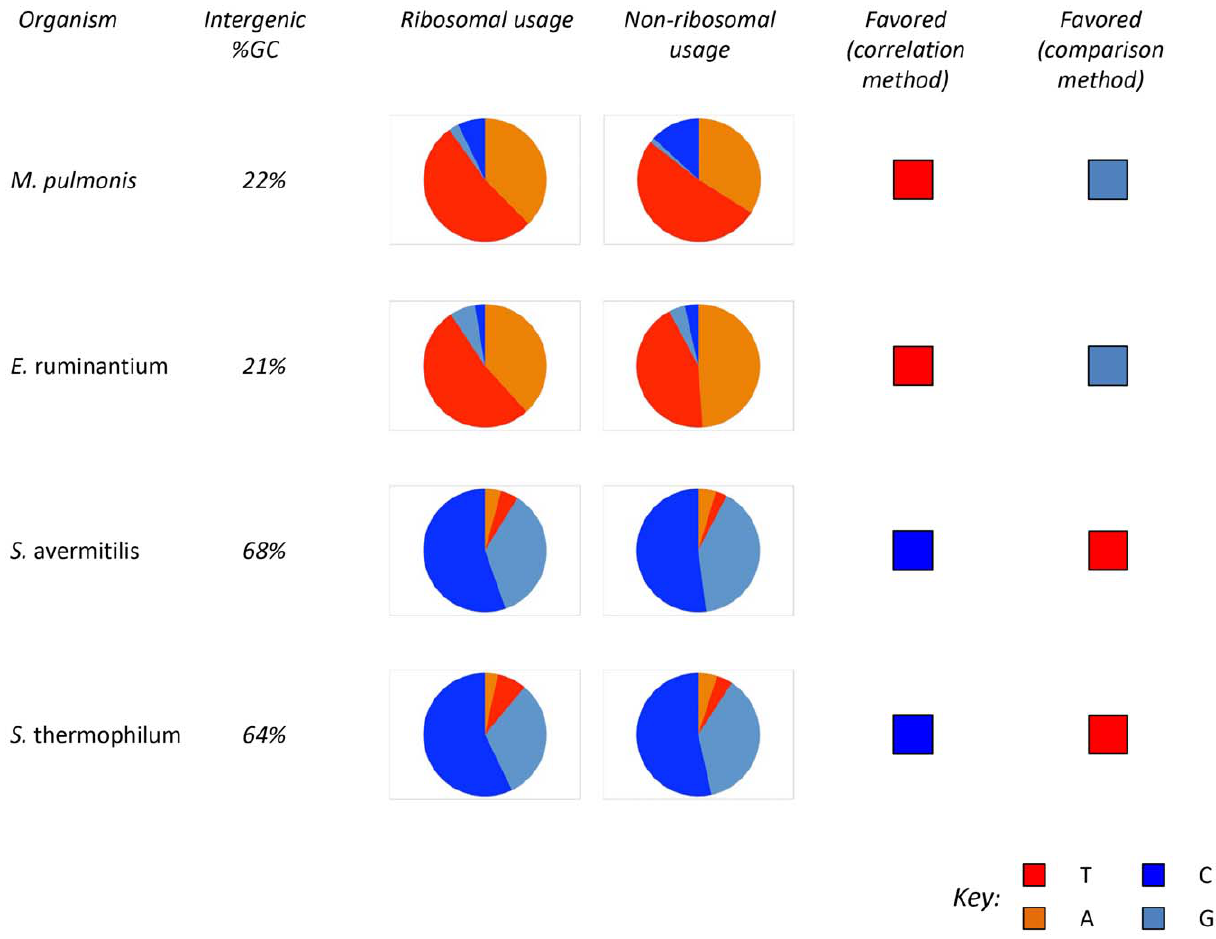
Figure 1. Favored codons identified using the comparison method are often incorrect. We present examples of the frequency distributions of all Alanine codons in ribosomal and non-ribosomal genes, in four randomly selected bacterial genomes in which there is a disagreement regarding the codon identified as favored between our study (which used the correlation method) [12] and the study of Wang et al. (which used the comparison method) [13]. Alanine is a four-fold degenerate codon family, meaning the first two bases of the codon always remain the same. The data presented in this figure therefore focuses on the 3 rd codon position, which in the case of Alanine can be either A, or T, or G, or C. The results demonstrate that codons identified using the comparison method (as identified by Wang et al. ), are always so rare, and that their enrichment in ribosomal genes is so un-substantial that it does not appear likely that they are in fact favored.